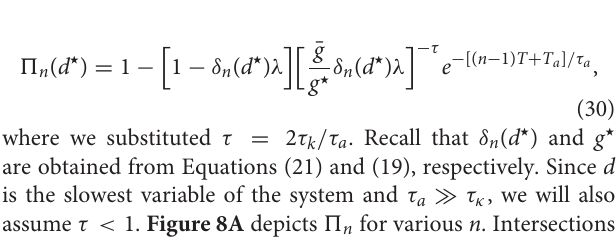
¯ g ≈ 0.0015 mS / cm 2 , curve 5 2 coalesces with the diagonal tangentially. When ¯ g > 0.0015 mS / cm 2 , a pair of fixed points emerge, one stable and one unstable fixed point, indicating the occurrence of a fold bifurcation of